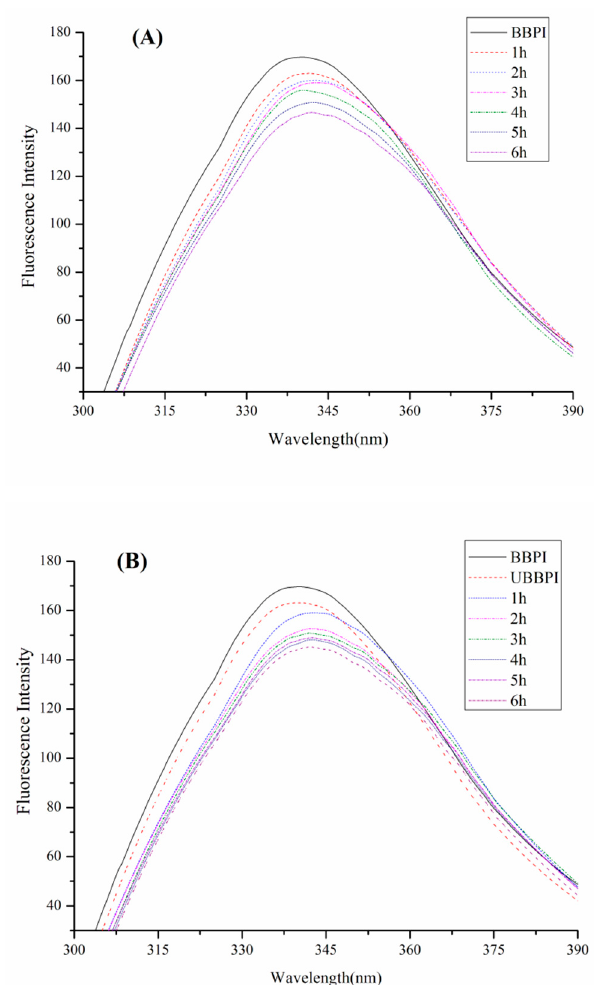
Figure 2. Fluorescence intensity of BBPI by wet heating ( A ) and ultrasound treatment Maillard reaction ( B ) respectively obtained at the indicated reaction time for 1–6 h.